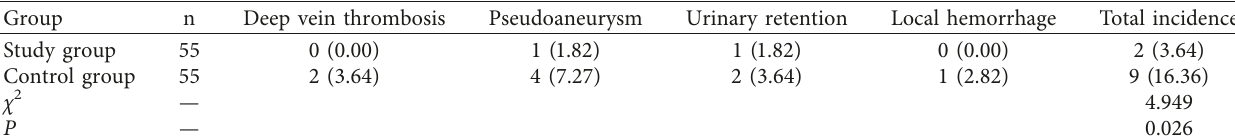
Table 6: Comparison of complications between the two groups (n,